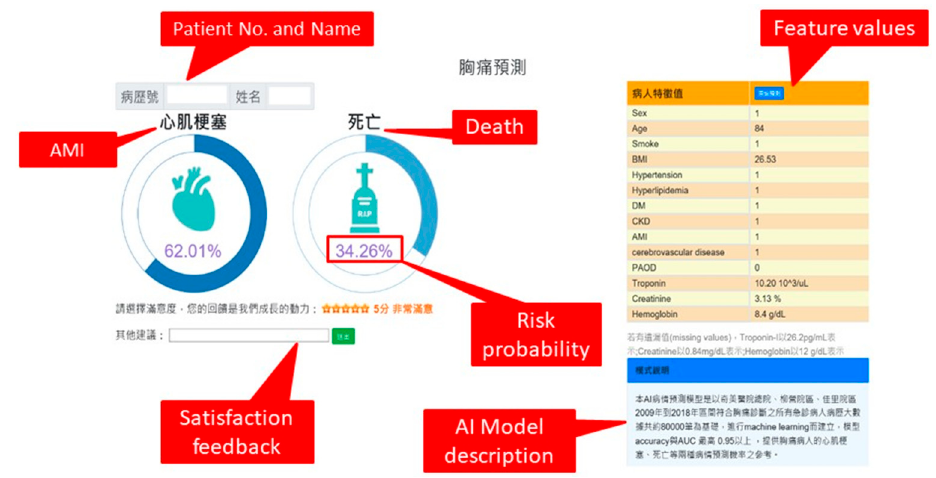
Figure 3. A Screenshot of a Deployed AI System.